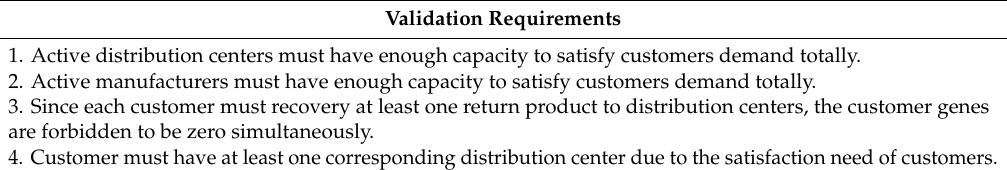
Figure 9. The network of offspring.